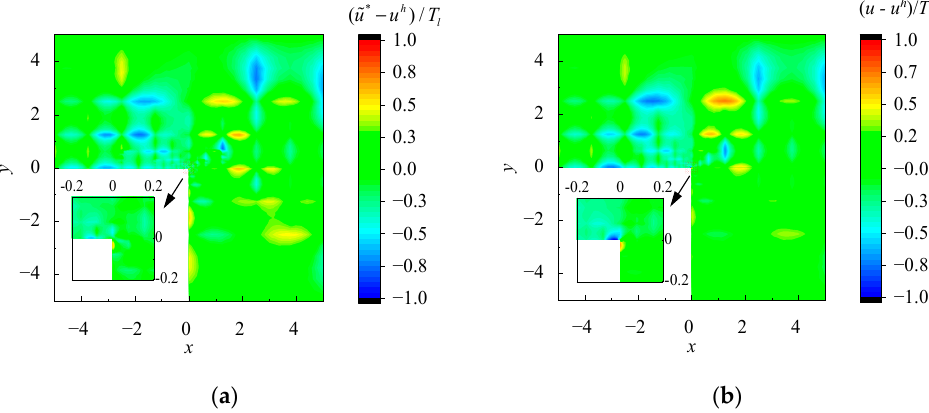
Figure 21. Adaptive FE mesh: ( a ) mesh π ∗ and ( b ) final mesh π .